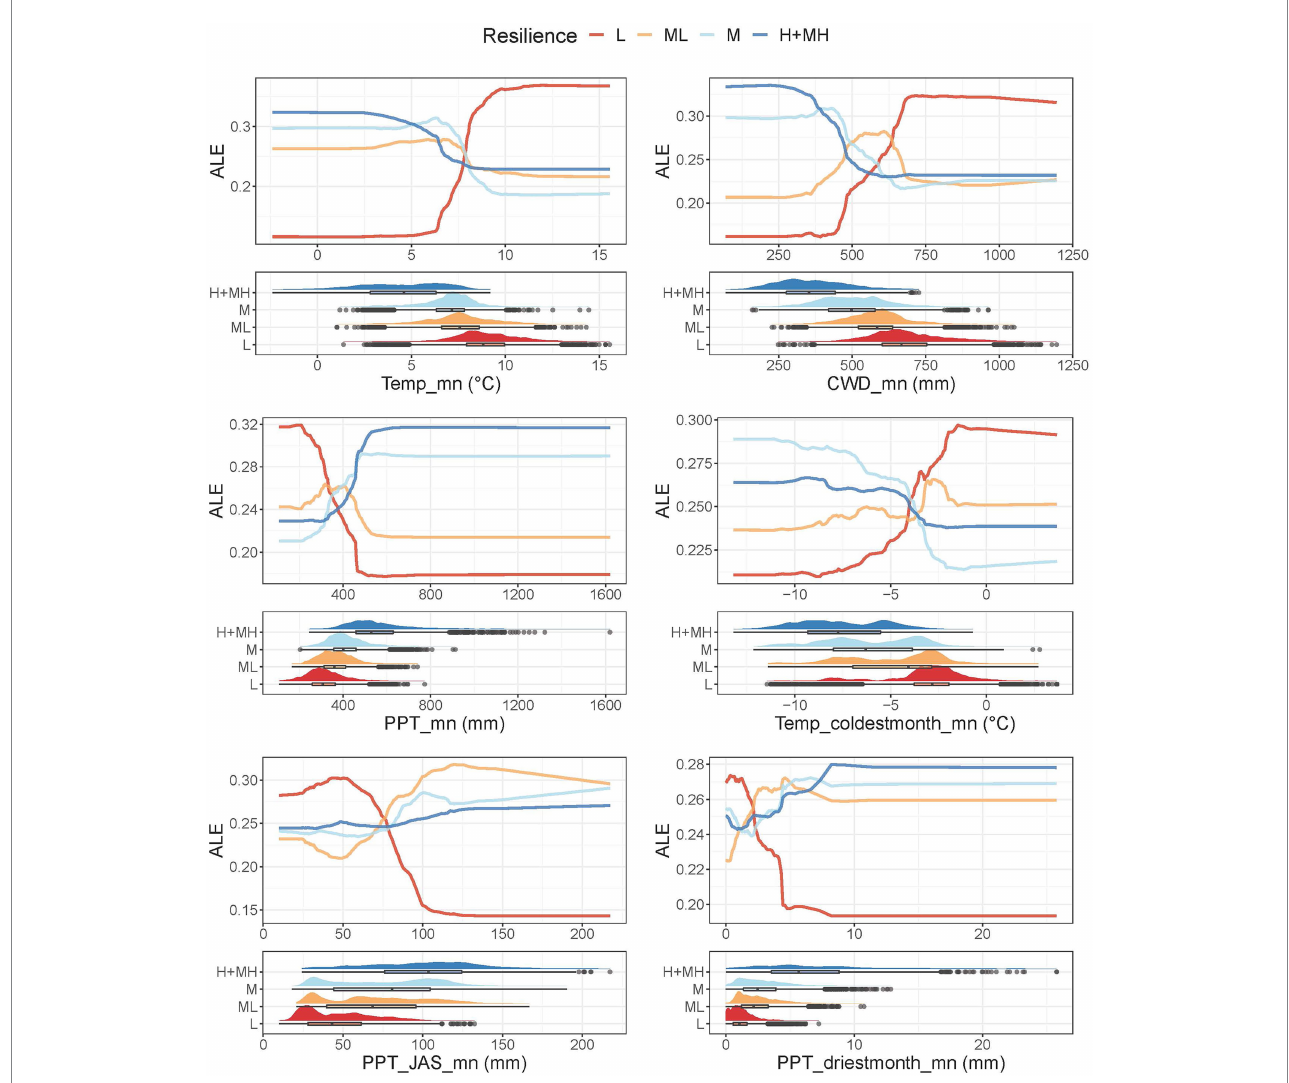
FIGURE 3 Accumulated local profile (ALE) plots and halfeye/box plots for the most highly ranked indictors of resilience. The ALE plots show effects of the focal variable on the random forest classification conditioned on the effects of other variables in the model. Halfeye/boxplots illustrate density of the raw data combined with a boxplot showing the median at the box’s center, the first and third quartiles (25th and 75th percentiles) as the box’s hinges, and whiskers extending to the largest and smallest values no further than 1.5 times the interquartile range from the hinge. Additional outliers are plotted as open